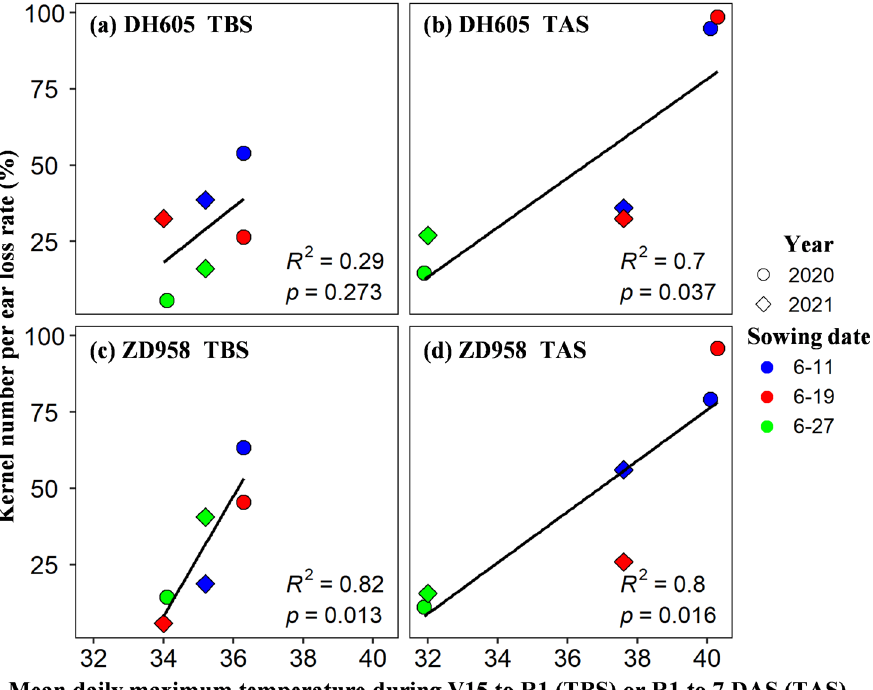
Figure 6. The relationship between kernel number loss rate of DH605 ( a,b ) and ZD958 ( c,d ) and mean daily maximum temperature during V15-R1 + 7 d under TBS ( a,c ) and TAS ( b,d ) conditions (TBS: V15-R1; TAS: R1-7 DAS).